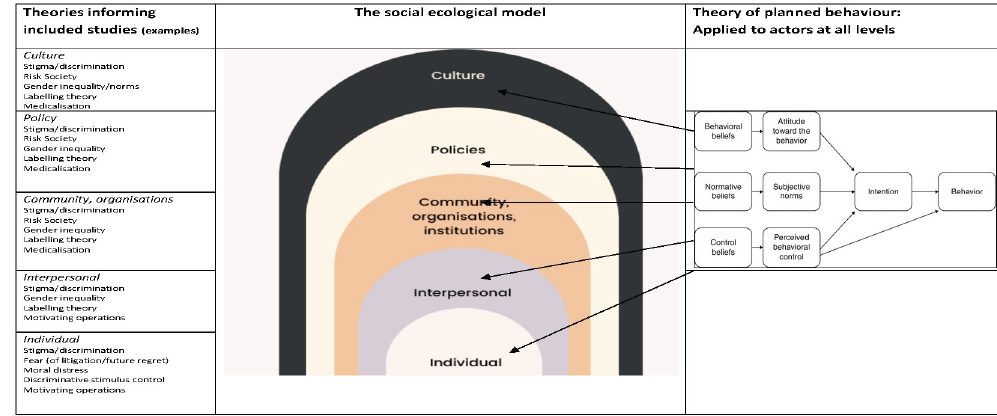
Fig 10. Proposed socio-ecological-behavioural approach linked to example theories from included